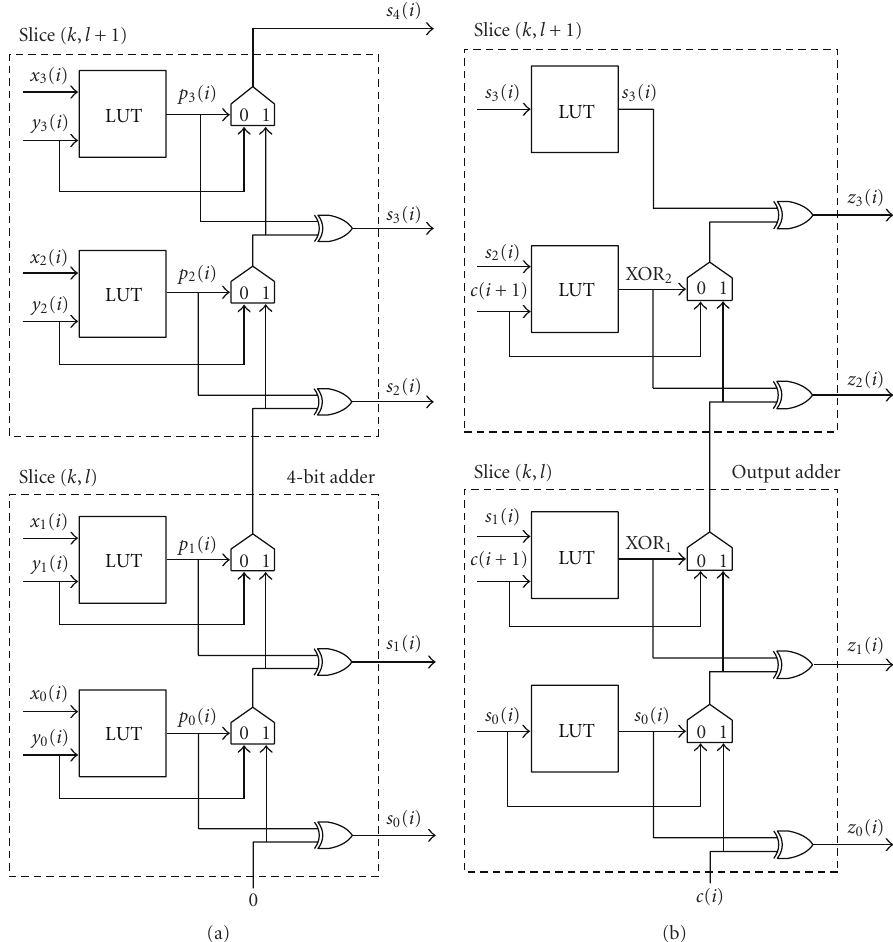
Figure 8: FPGA implementation of adders: (a) 4-bit adder stage and (b) output adder